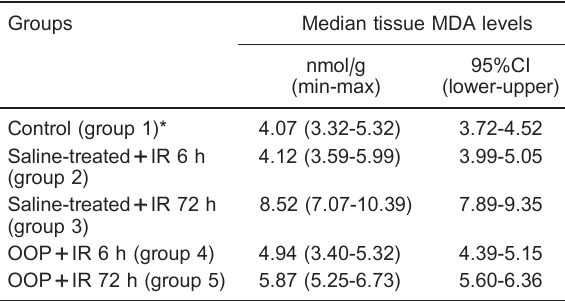
Table 3. Tissue MDA levels of control, saline-treated++IR, or OOP++IR groups decapitated at 6 or 72 h after irradiation. Groups